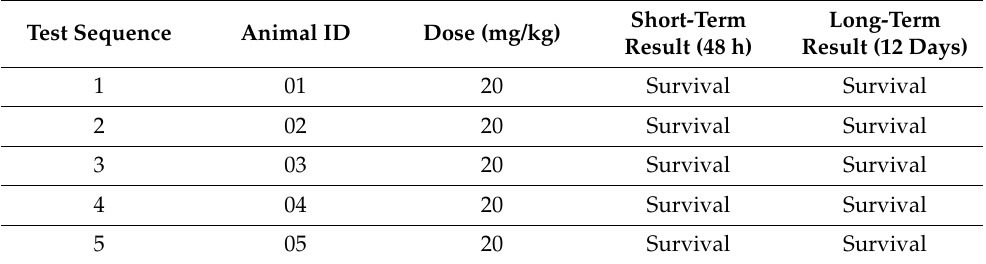
Table 1. Sequence and results of limit dose test of TMNB in rats. Test